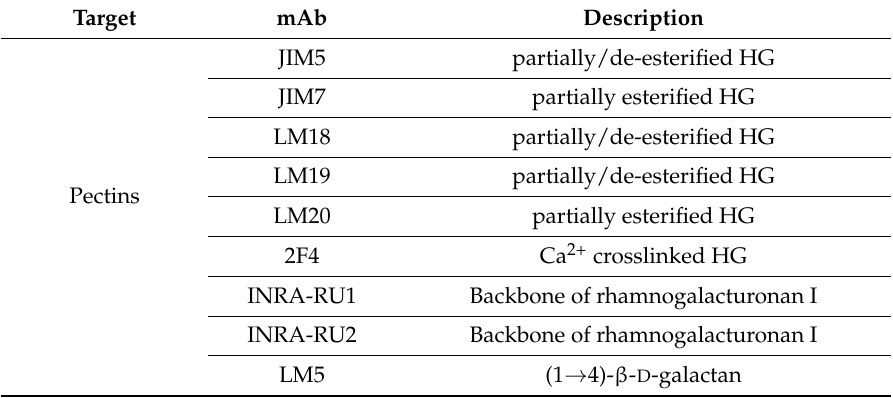
Table 1. List of monoclonal antibodies (mAbs) used in this study. HG: